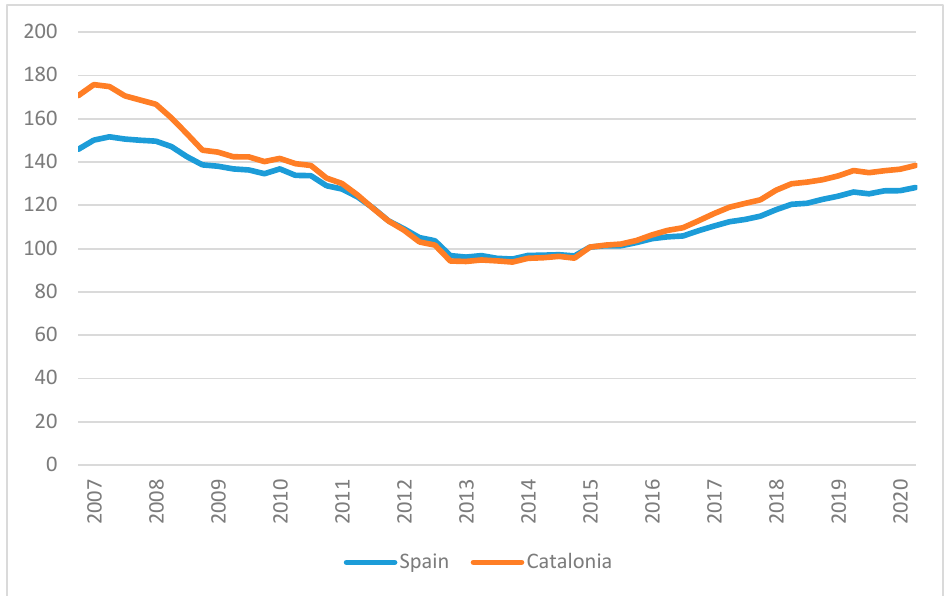
Figure 1. Price per square meter in the free market of dwellings (1995–2020). Source: Ministry of Transport, Mobility and Urban Agenda (Ministerio de Transportes, Movilidad y Agenda Urbana) [74].